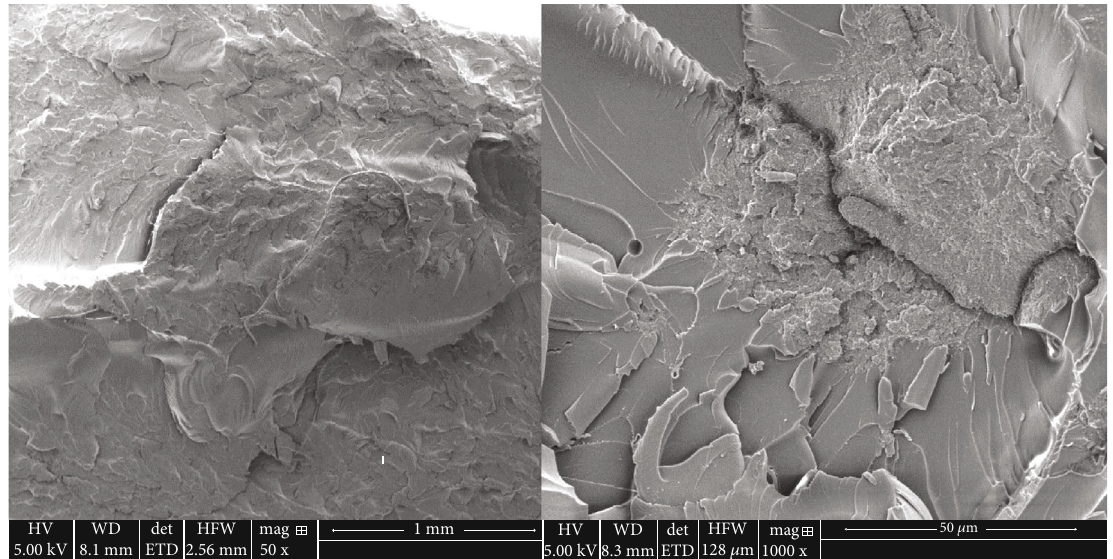
Figure 14: Fracture surfaces due to tensile failure in a 0.5wt.% MWCNT-reinforced epoxy composite at room